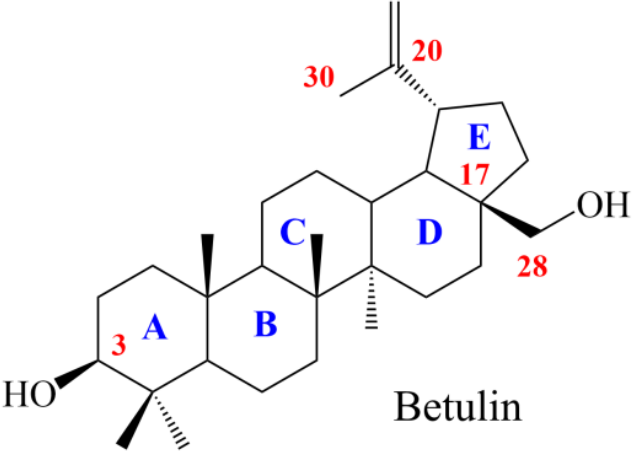
Figure 1. Structure of betulin.